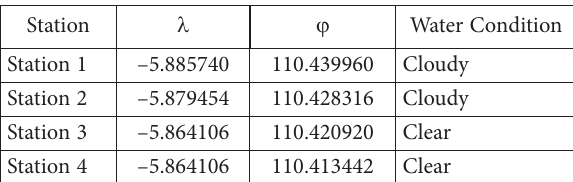
Table 3. Location of field spectral station ( water attenuation )